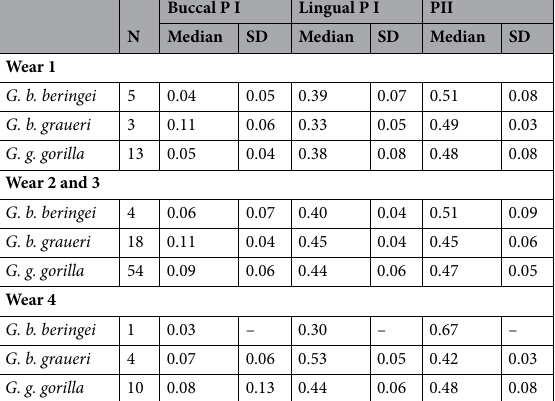
Table 1. Summary statistics (median and SD) of relative wear facet areas divided by wear